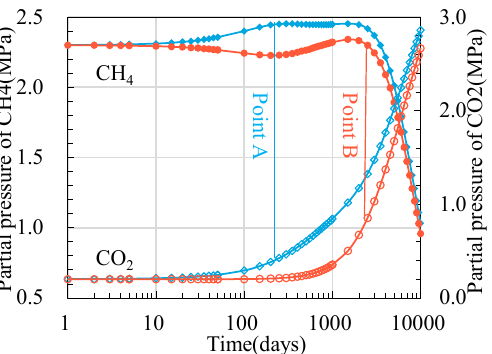
Figure 12. Evolution of partial pressure of CH 4 and CO 2 in the matrix at point A and point B. Point A